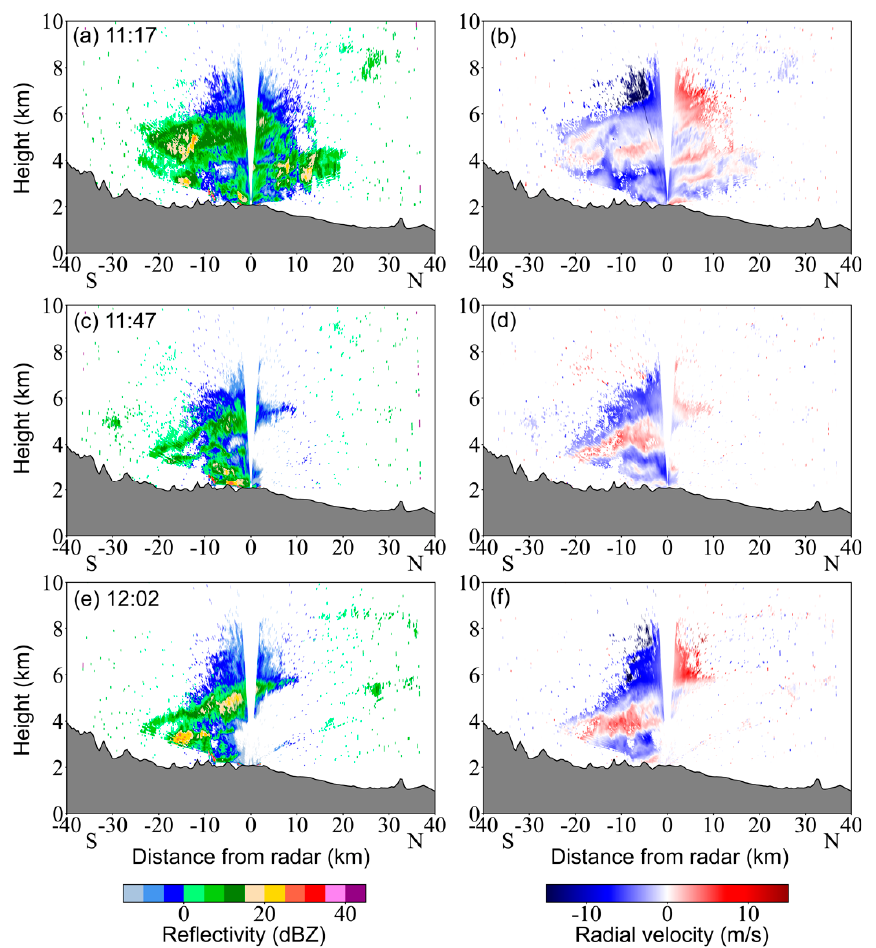
Figure 8. RHI measurements of ( a , c , e ) reflectivity and ( b , d , f ) radial velocity conducted by the cloud radar for Segment 3. S and N below each panel indicate south and north of the cloud radar. The blue color in the panels of radial velocity indicates flow towards the radar, while red indicates flow away from the radar.